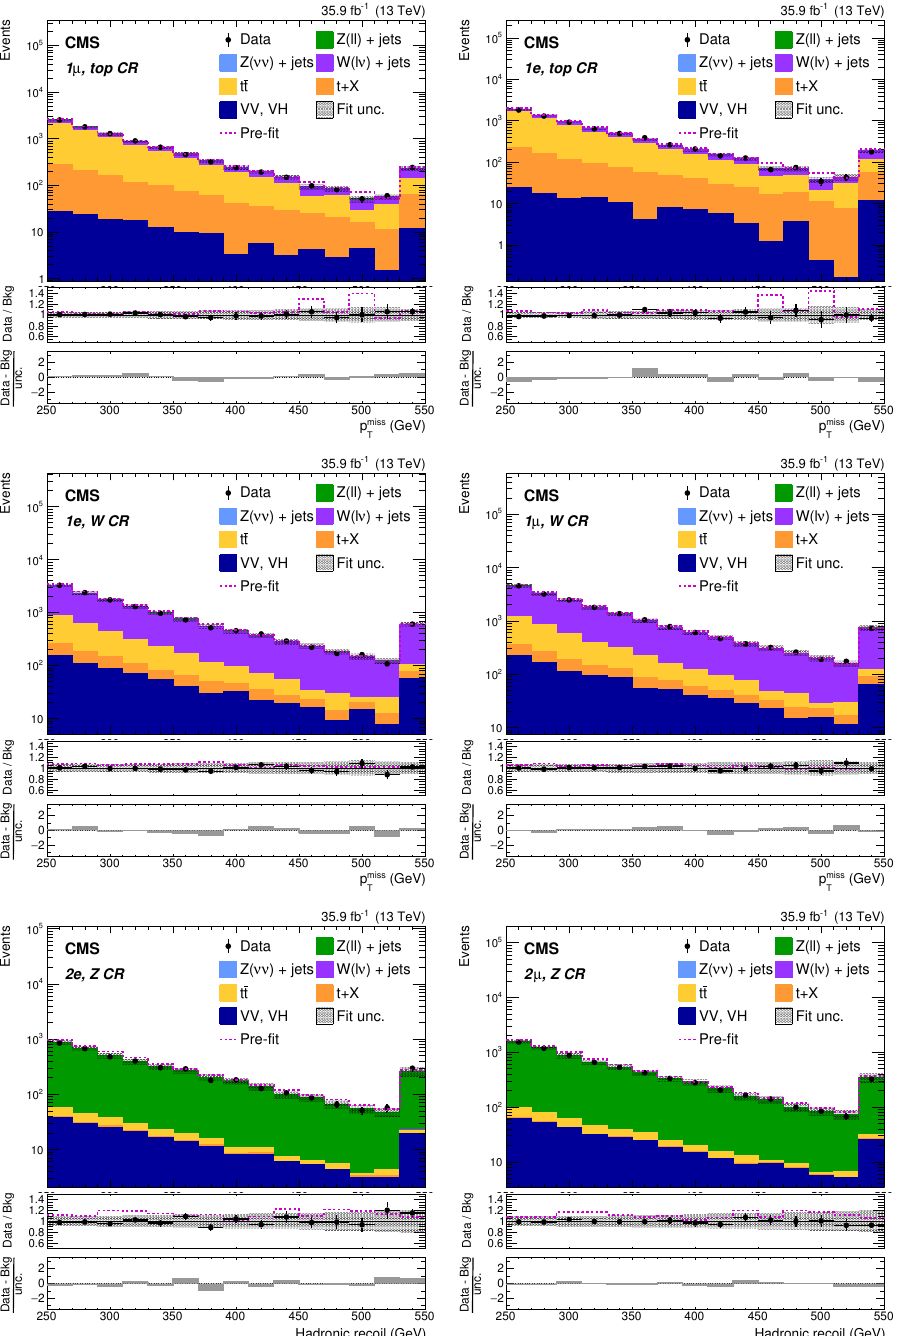
Figure 3 . Background-only post-(cid:12)t p miss distributions for the CRs of the AH selection. The total T theory signal (t = t+DM and tt+DM summed together) is negligible and therefore is not shown. The last bin contains over(cid:13)ow events. The dashed magenta lines show the total pre-(cid:12)t background expectation in the upper panels, and the ratio of pre-(cid:12)t total background to post-(cid:12)t total background in the middle panels. The lower panels show the di(cid:11)erence between observed and post-(cid:12)t total background divided by the full statistical and systematic uncertainties.